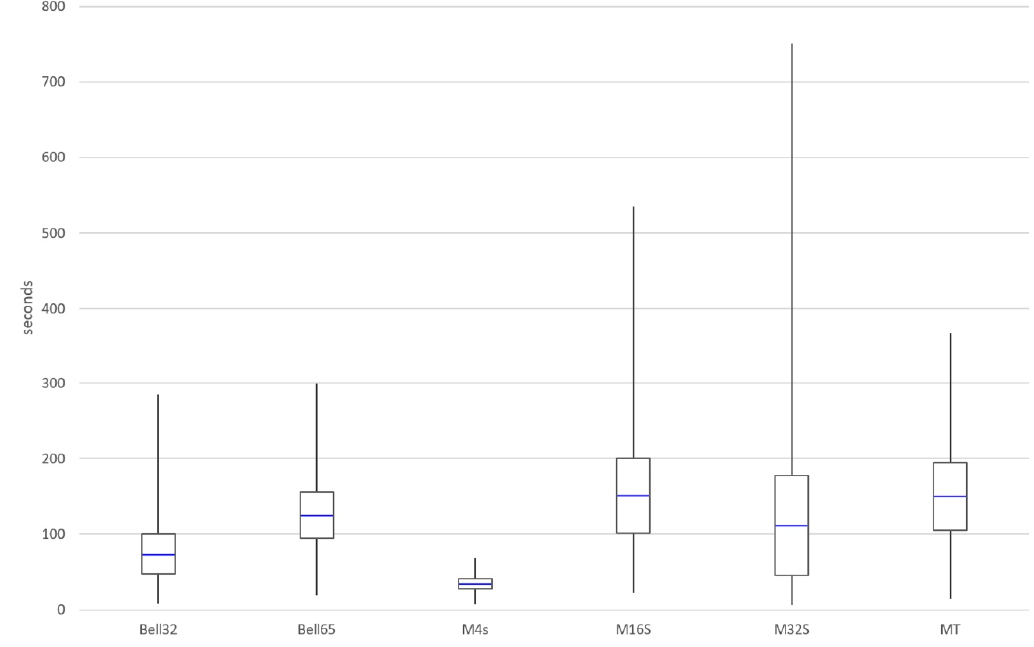
Figure 15. Statistical comparison of the different simulated configurations.